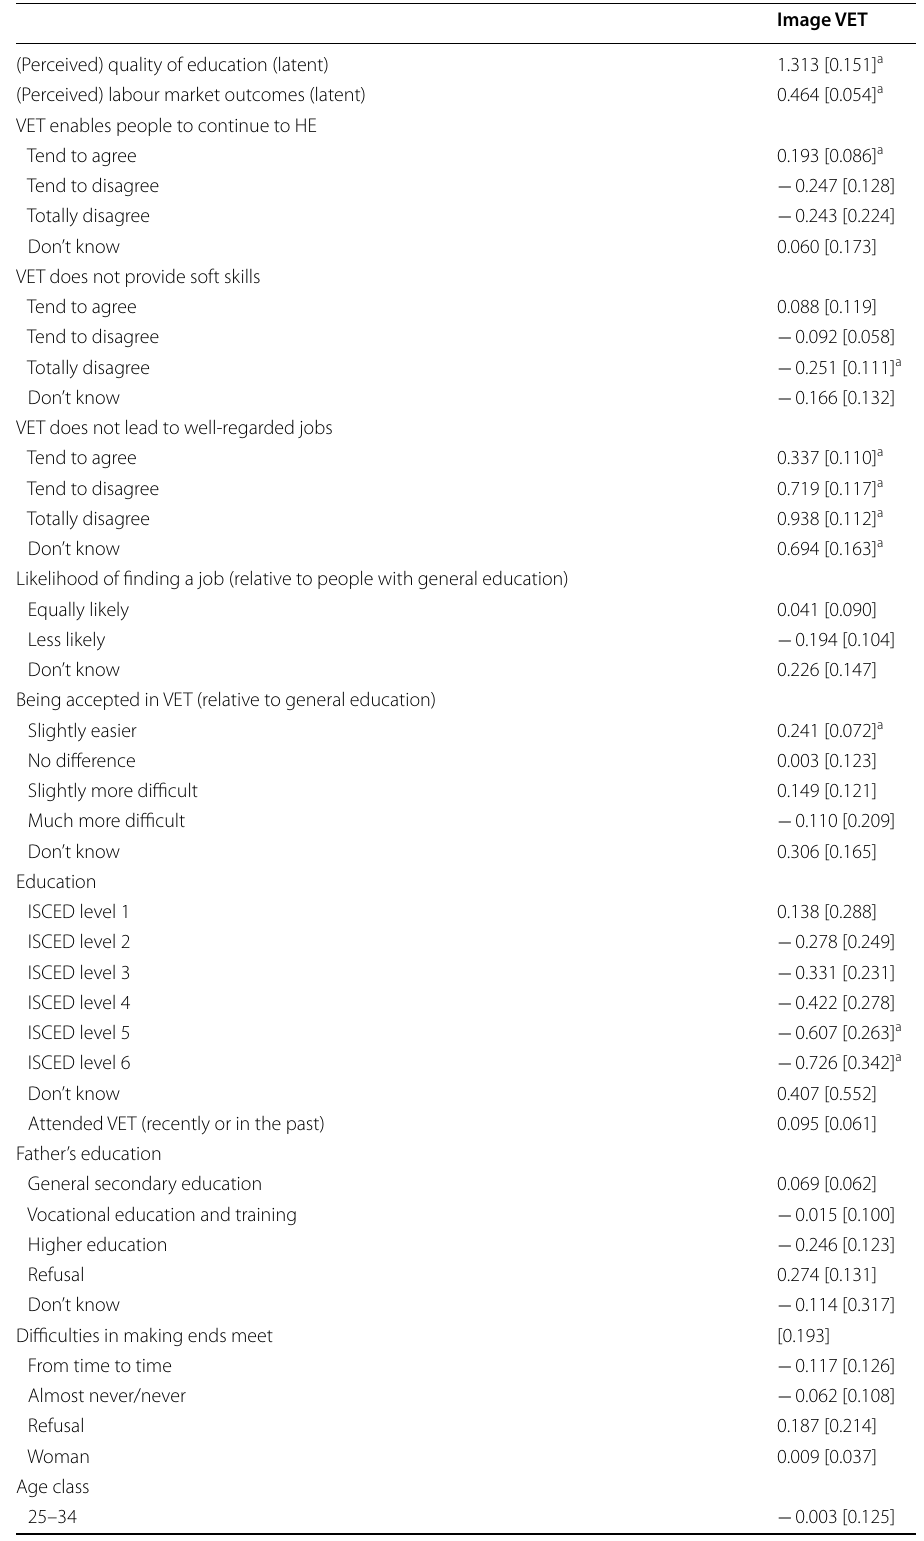
Table 7 Attitudes towards VET, weighted data (clustered standard error in brackets)